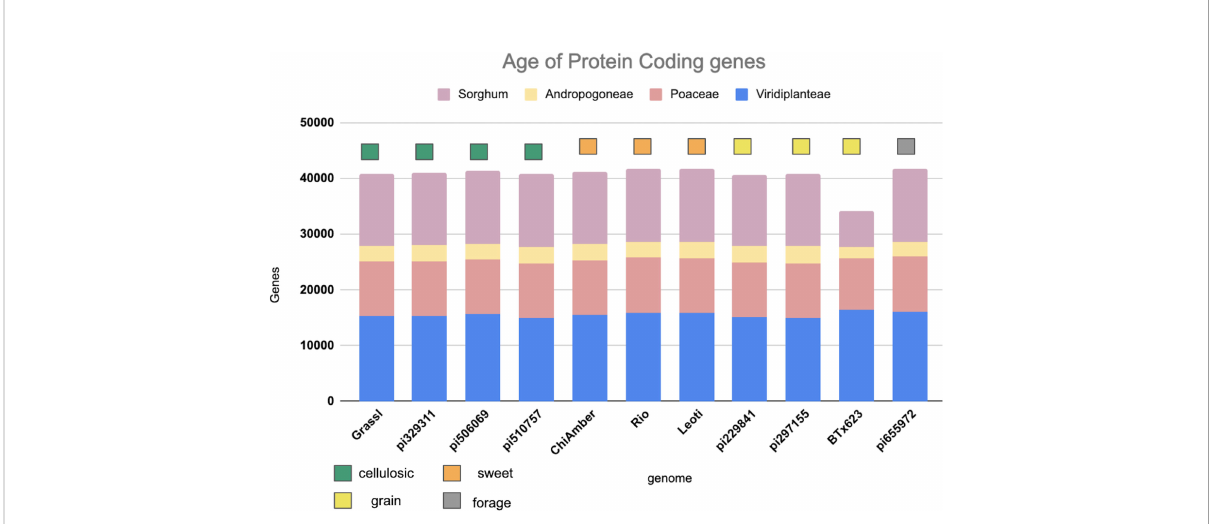
FIGURE 2 Age of protein coding genes among the sorghum lines based on minimum sequence identity. Bar color indicates the level of phylogenetic conservation, with blue indicating genes conserved across monocots and dicots; peach indicating the proportion of genes shared among the grasses; yellow indicating the proportion of genes shared between sorghum and maize, and light purple representing the proportion of sorghum-speci fi c